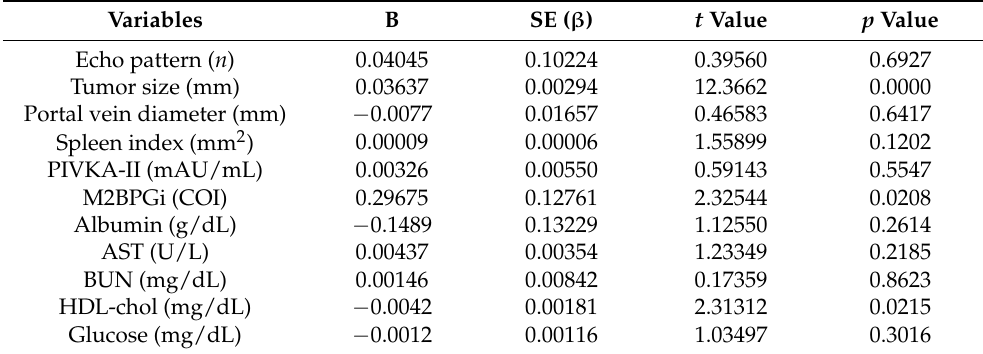
Table 6. Multiple regression analysis of variables associated with numbers of abnormal coagulation factors in 281 patients with hepatic